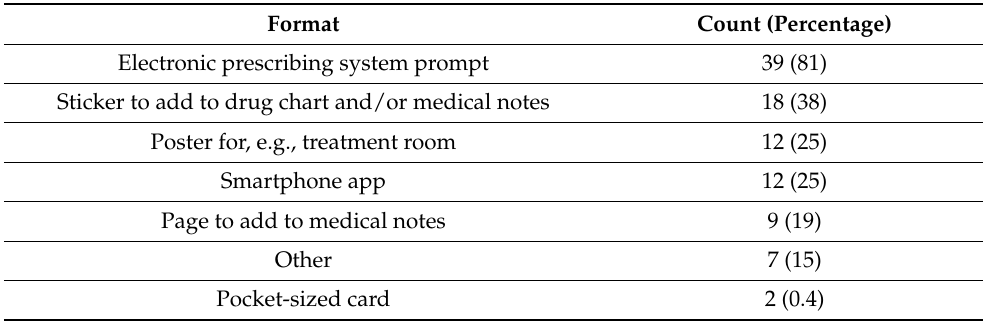
Table 4. Survey respondents’ ideal formats to deploy the IVOS criteria for implementation in hospital settings.